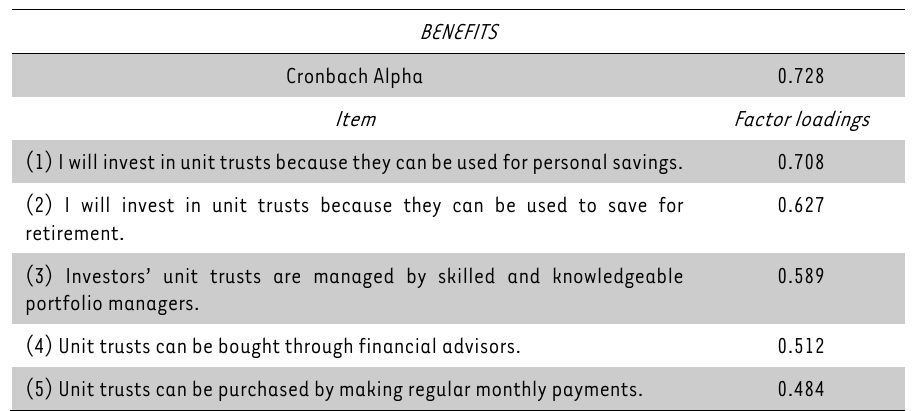
TABLE 1: Factor 1 -